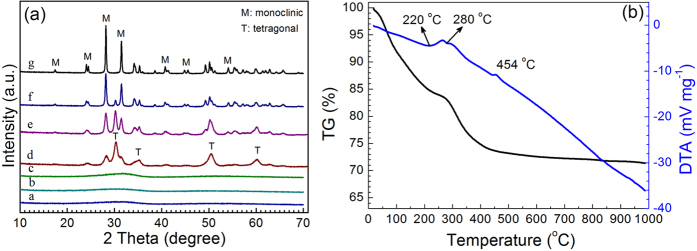
(a) XRD patterns of the (a) ZrO2 precursor, (b) powder after azeotropic distillation, and ZrO2 HSNCs calcined at (c) 300 °C, (d) 400 °C, (e) 600 °C, (f) 800 °C, and (g) 1000 °C. Synthesis conditions: n (NH4HCO3)/n (zirconium ions) = 2; CZr = 0.15 mol L−1; pH = 5.1~5.8; tcalcination = 2 h. (b) TG/DTA curves of ZrO2 precursor up to 1000 °C in air.